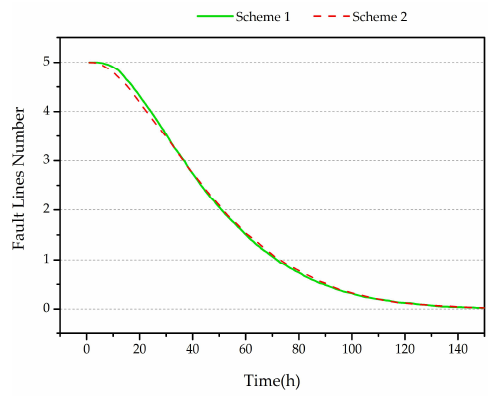
Figure 6. Fault lines repair process.